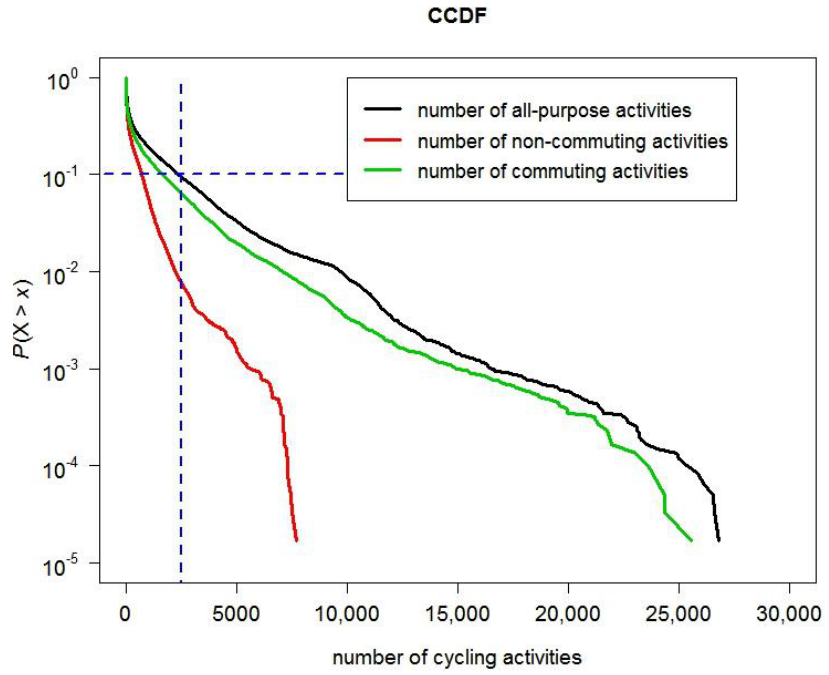
Figure 2. Cumulative distributions of numbers of all-purpose cycling activities, non-commuting cycling activities and commuting cycling activities in the log-linear plot.